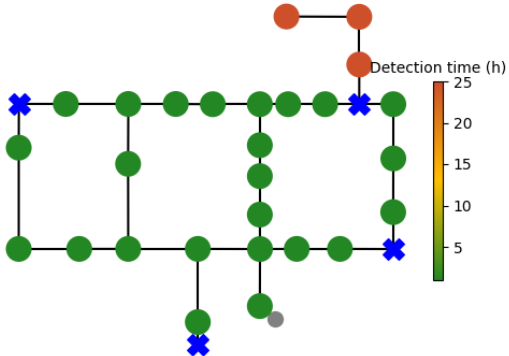
Figure 10. Optimal sensor placement on the Hanoi WDN. Blue crosses are sensor locations and the colors denote the detection time. The grey node is a reservoir, which is not considered a possible sensor location.